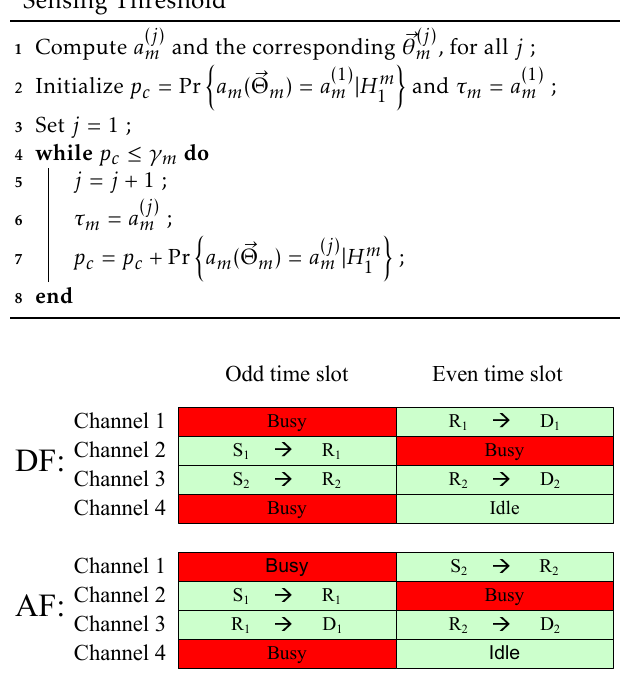
Figure 4. Illustration of the protocol operation of AF and ⇒ R DF, where S represents the transmission from source to i i ⇒ D relay and R represents the transmission from relay to i i destination, for the i th cooperative relay